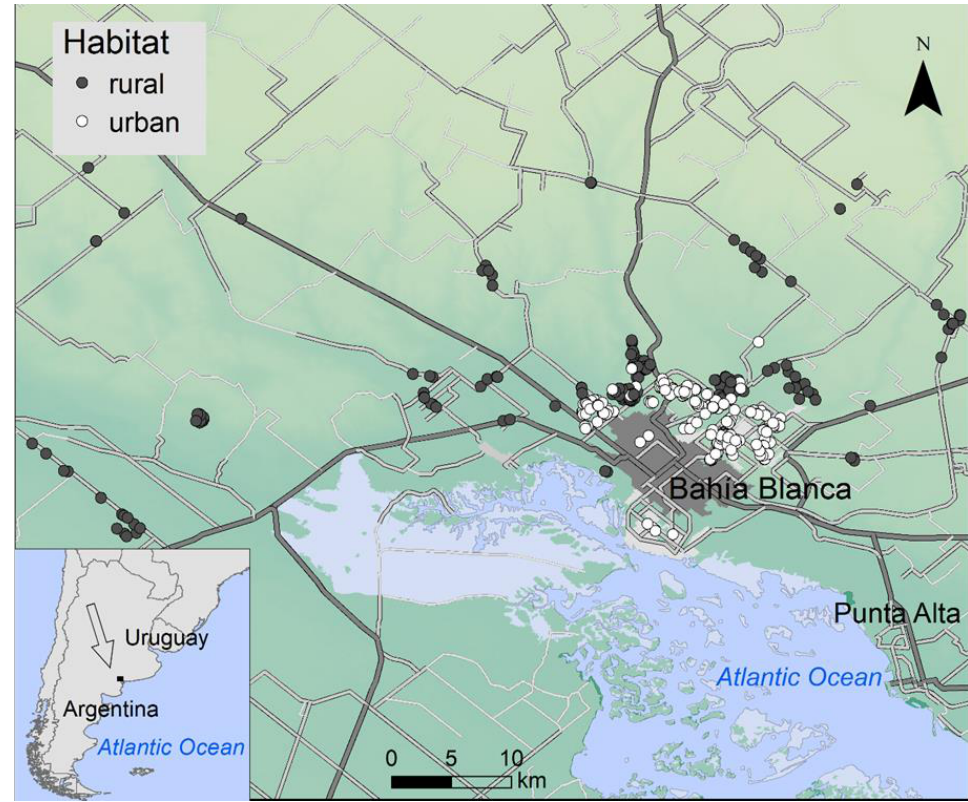
Figure 1. Location of the study area. Grey and white dots show the location of rural and urban nests sampled, respectively. Paved (grey) and unpaved (white) roads are also shown.